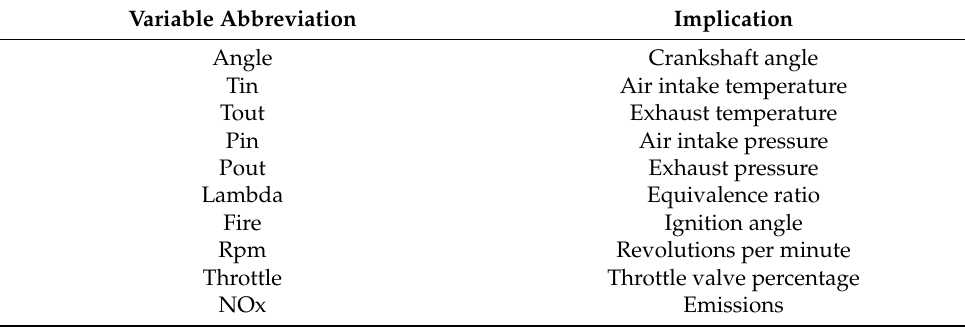
Table 3. Implications of Variables in Figures 10 and 11.